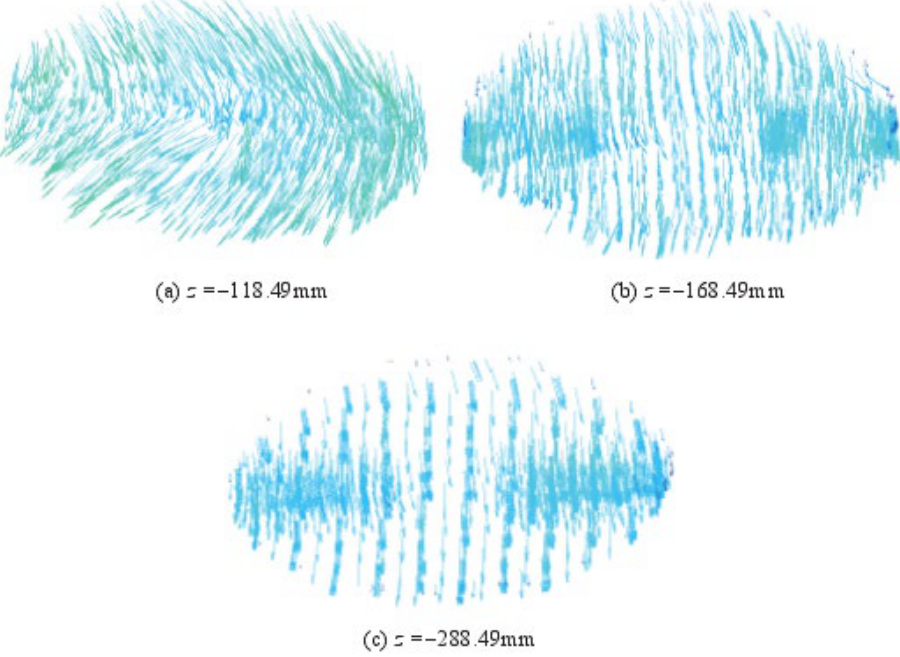
Figure 13. Velocity vectors of different sections of draft tube with diversion baffle scheme [61].